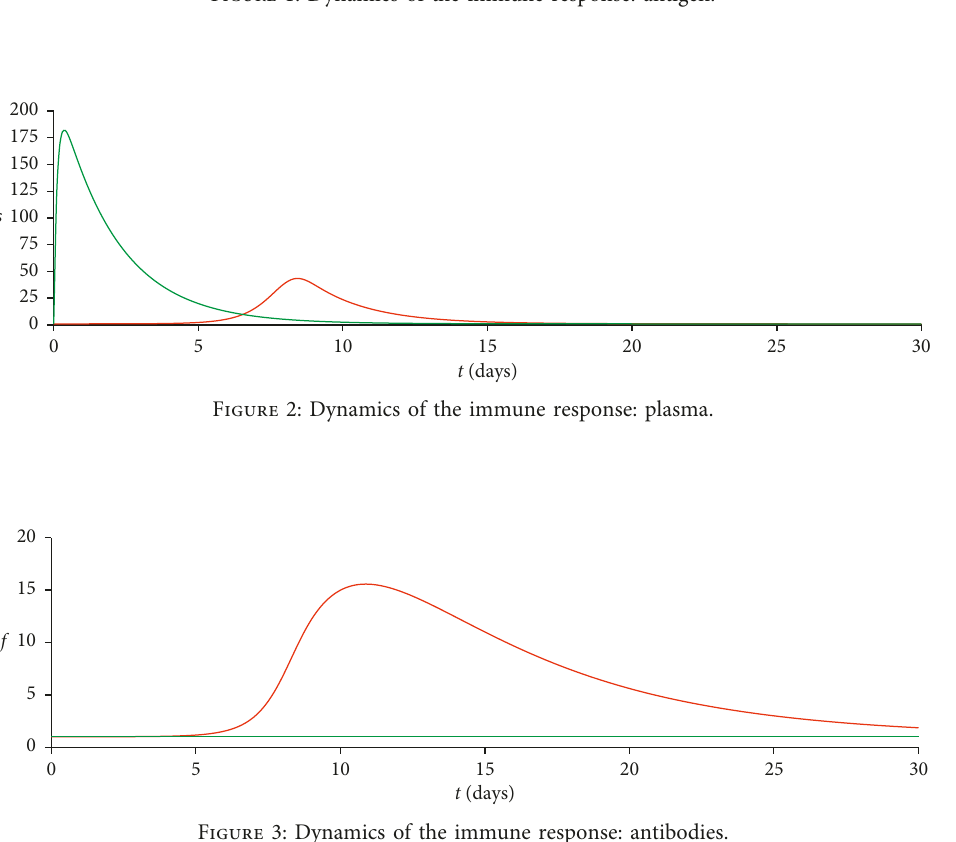
Figure 1: Dynamics of the immune response: antigen.